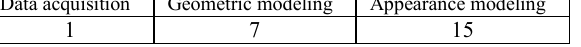
Table 1: Approximate time ratio between the data acquisition, and the realization of the final textured 3D model of the globe. The project is still on-going and the next steps include the creation of LOD-based versions of the 3D globe for different (web-based visualization, sharing, restoration,